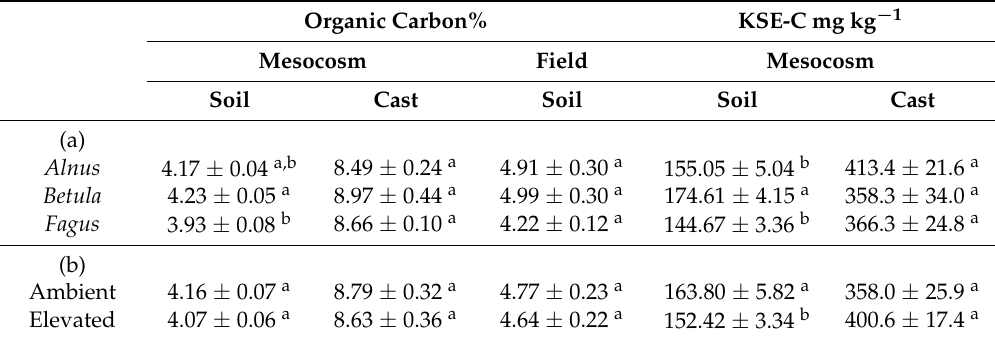
Table 6. Effect of ( a ) litter species and ( b ) CO 2 regime on organic carbon and K 2 SO 4 extractable carbon (KSE-C) in aggregates from the mesocosm and field experiments.